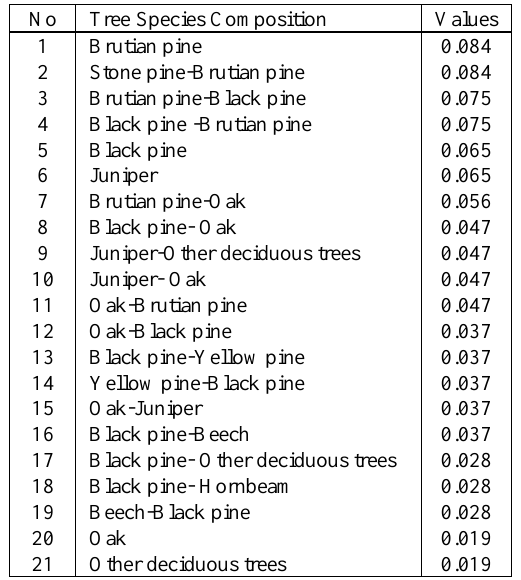
Table 10. The weighted values of tree species Table 11 indicates the weighted values of crown closure criteria